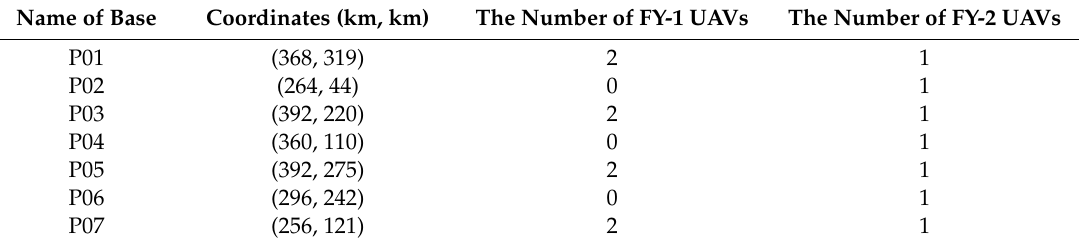
Table 1. The configuration of unmanned aerial vehicles (UAVs) for each base.